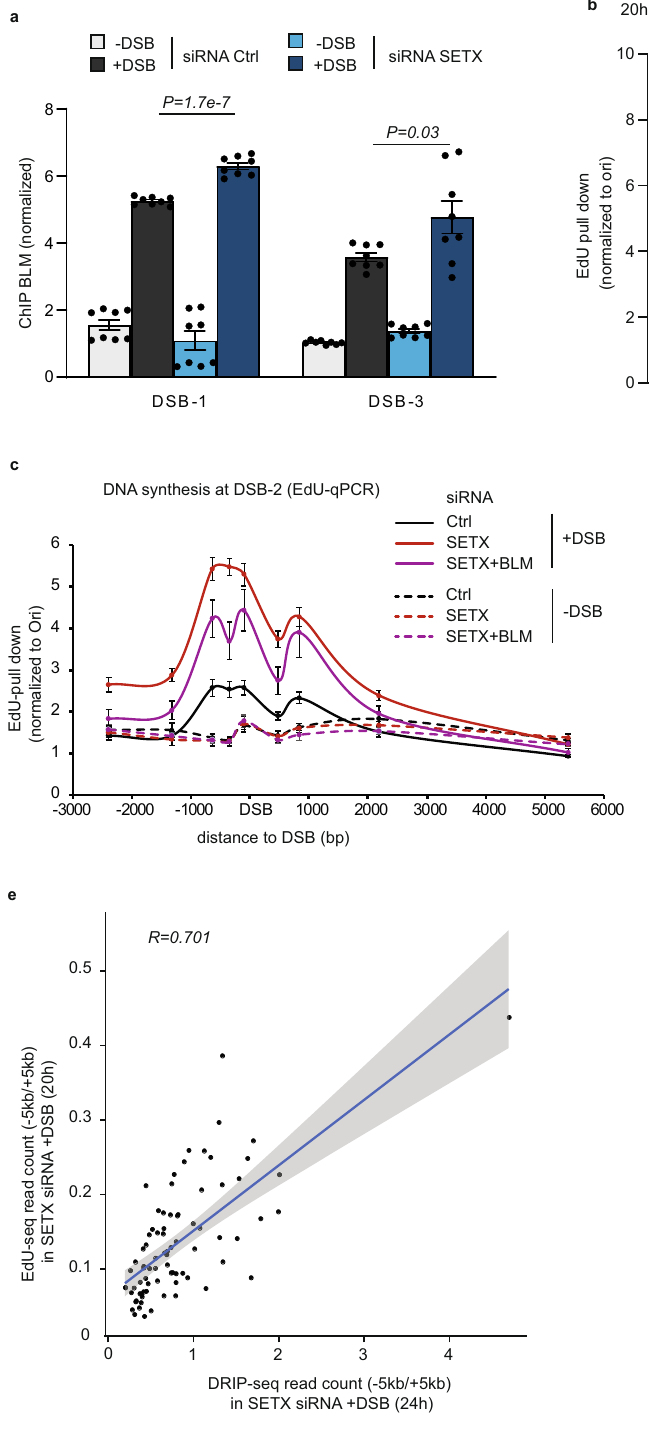
removal. BLM depletion was indeed able to partially rescue SETX-induced lethality while not being able to restore RAD51 foci formation. Hence the toxicity of sustained DSB-induced RNA:DNA hybrids is not due to a decreased HR capacity. Rather we found that BLM and POLD3-dependent DNA synthesis is responsible for increased cell death induced by TC- DSBs when R-loop resolution is impaired. Indeed (i) depletion of POLD3/POLD1 and BLM rescues lethality upon DSBs in active genes in a SETX-depleted background, (ii) excessive DNA synthesis takes place at DSBs upon SETX depletion despite